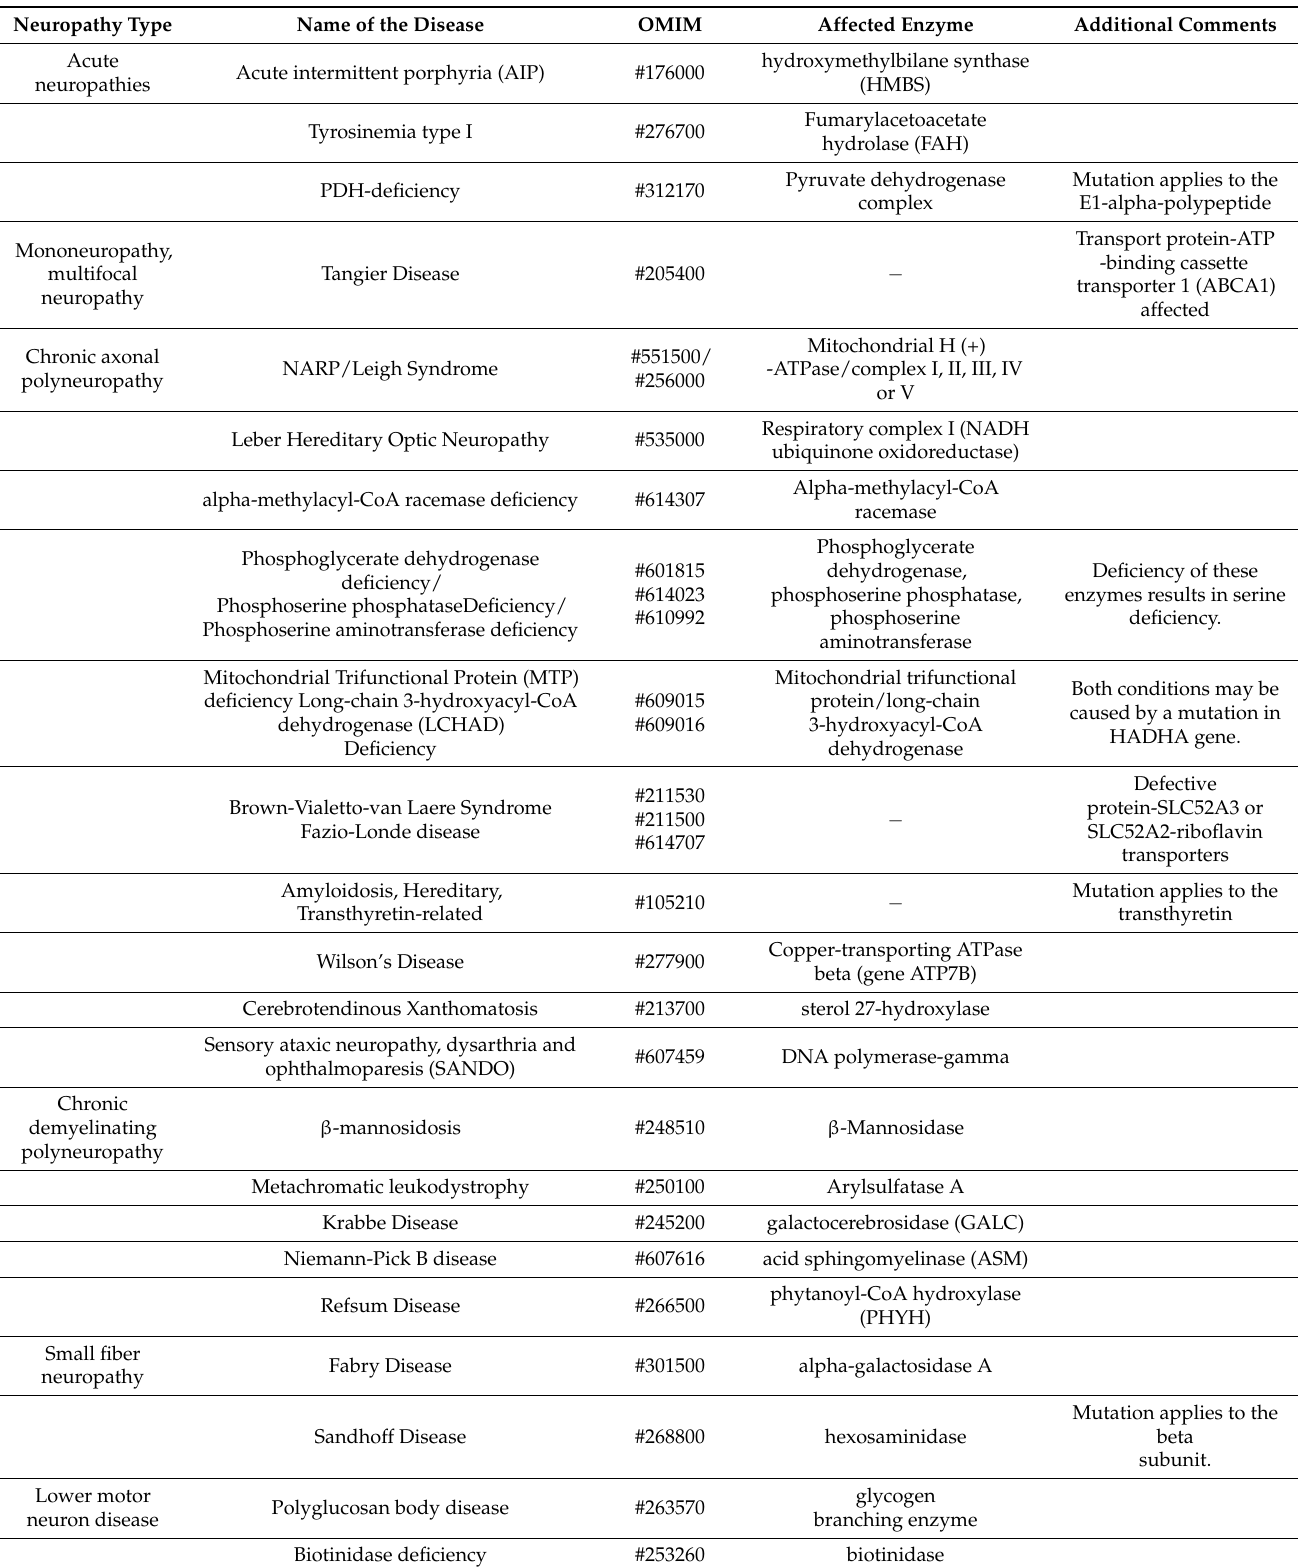
Table 1. A summary of neuropathy types in different